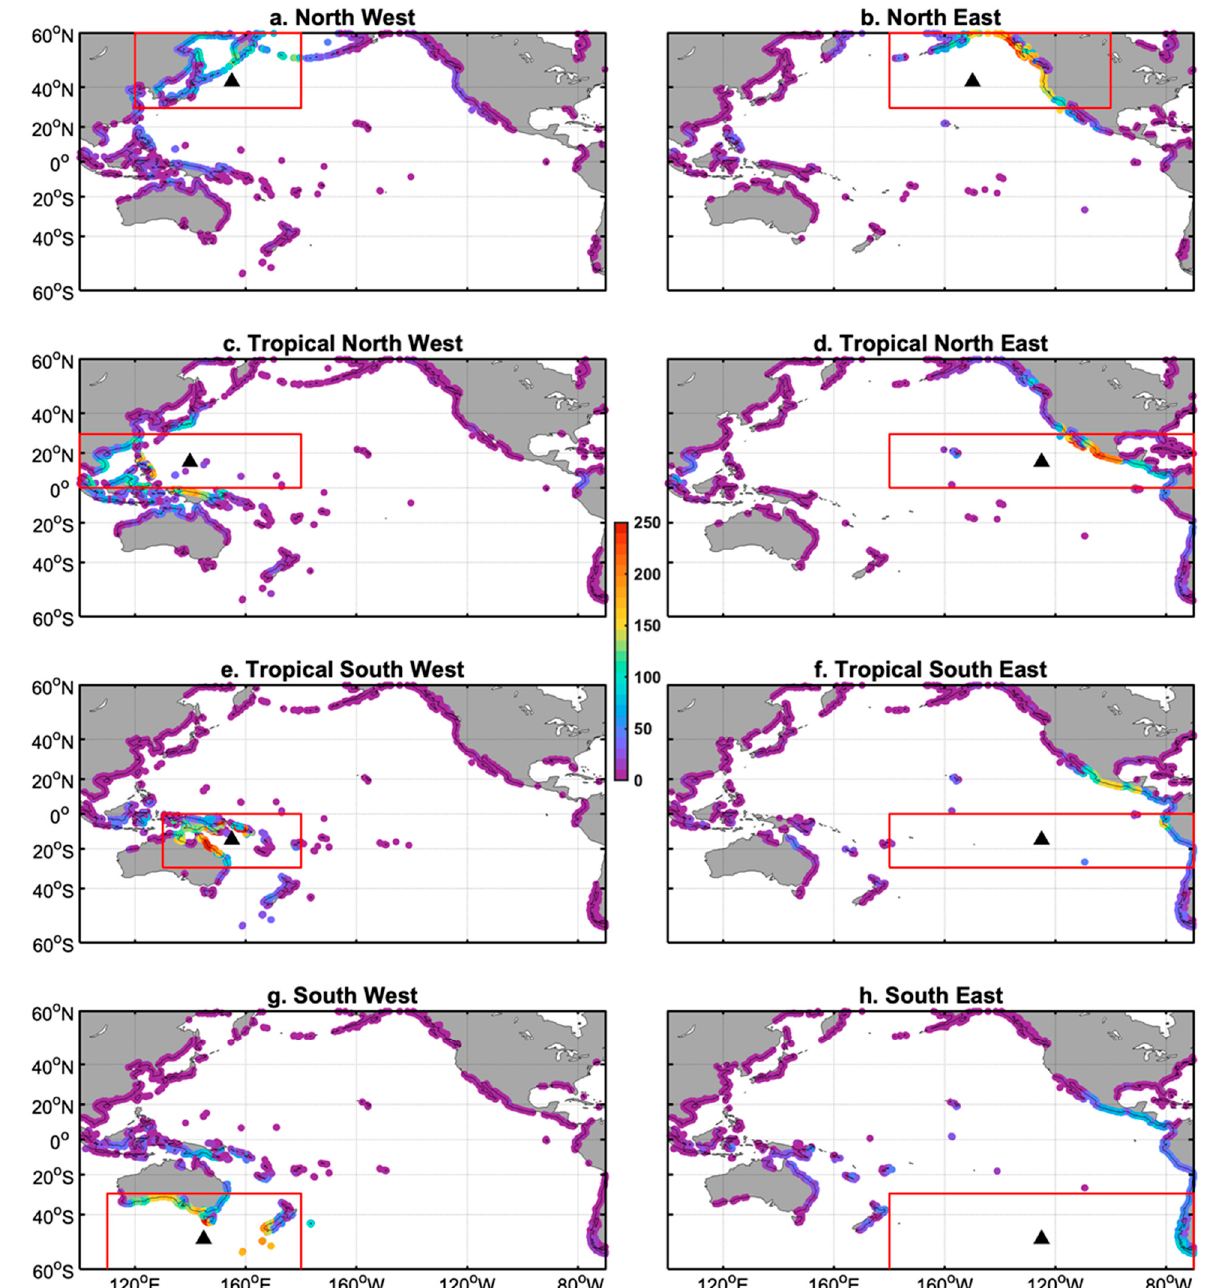
Figure 3. Spatial repartition around the Pacific Rim of the number of extreme coastal events that were generated in each open-ocean region (delineated by the red box in the corresponding panel) over the total period of 1979–2020. In the Pacific North-West ( a ), North-East ( b ) , Tropical North-West ( c ), Tropical North-East ( d ), Tropical South-West ( e ), Tropical South-East ( f ), South-West ( g ), and South-East ( h ).